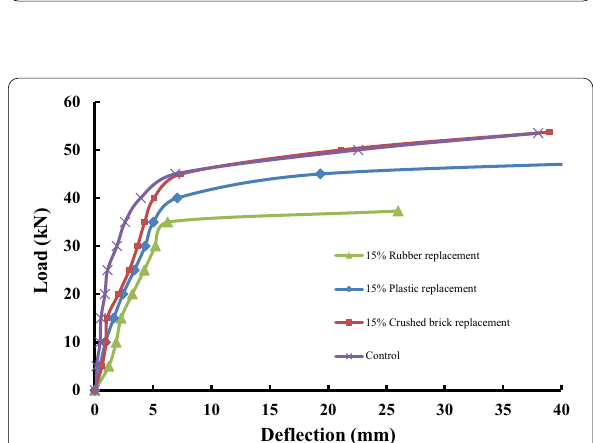
Fig. 12 Load–deflection for beams containing 15% of waste materials.